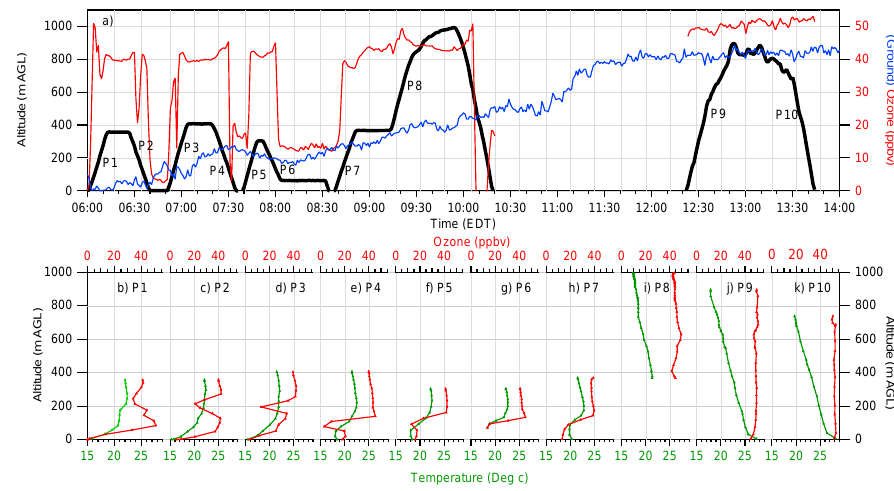
Fig. 9. (a) Time series for 7 July showing tethersonde elevation (black) and ozone mixing ratio (red) and ground-level ozone measured at the Ridgetown site (blue). (b–k) tethersonde vertical profiles of O 3 (red) and temperature (green) at Ridgetown. Profiles are numbered from P1 to